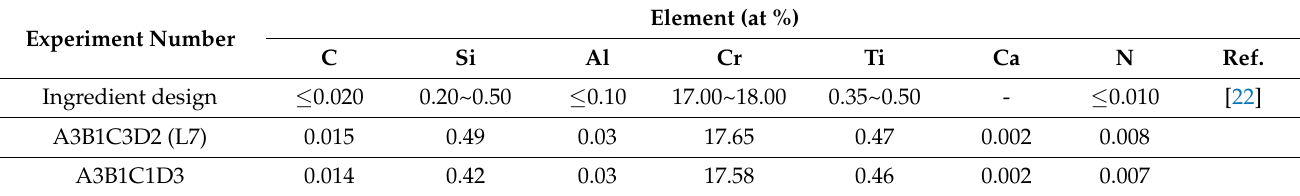
Table 8. Compositions of samples A3B1C3D2 (L7) and A3B1C1D3.